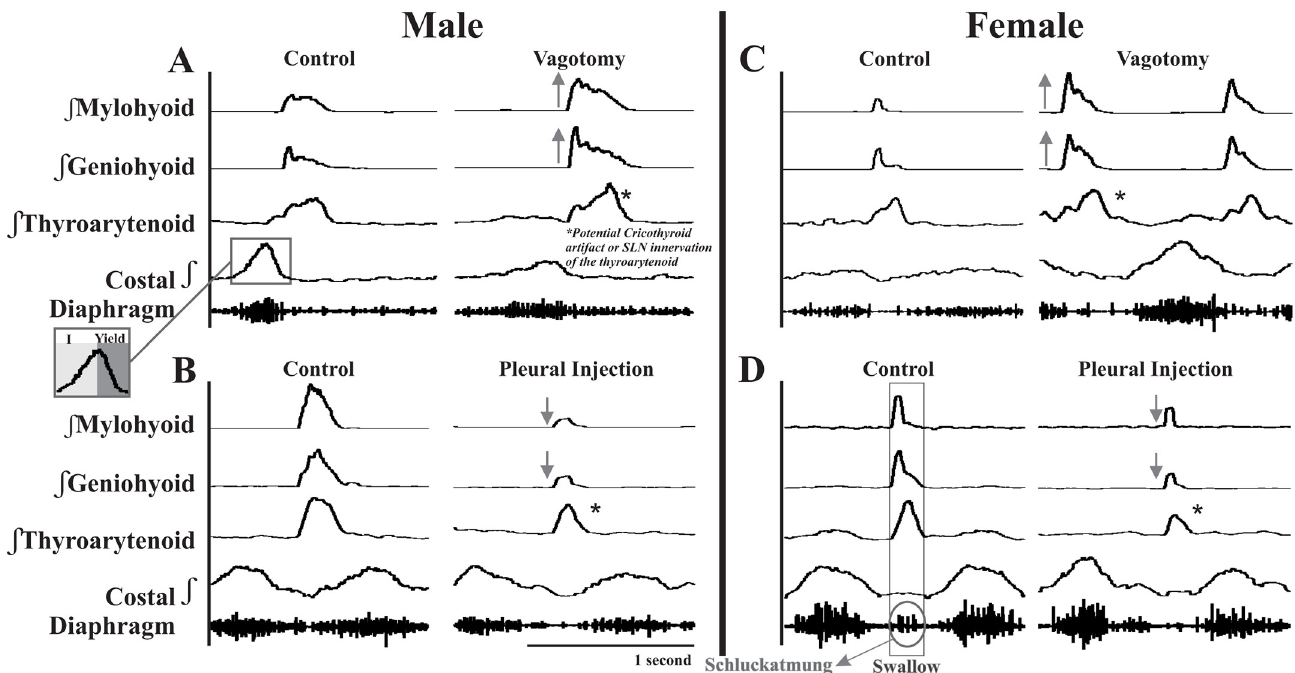
Fig 1. Representative EMG traces of swallow activity before and after afferent feedback manipulations. Panels A and B are recordings during swallows in male animals. Panels C and D are recordings in female animals. In both male and female animals, upper airway muscle amplitudes increase after vagotomy (A and C) and decrease after pleural injection (B and D). Panel A demonstrates the inspiratory and yield (remnant diaphragm activity in early expiration) components of breathing. Panel D displays schluckatmung (“swallow-breath”) diaphragm activation during swallow.